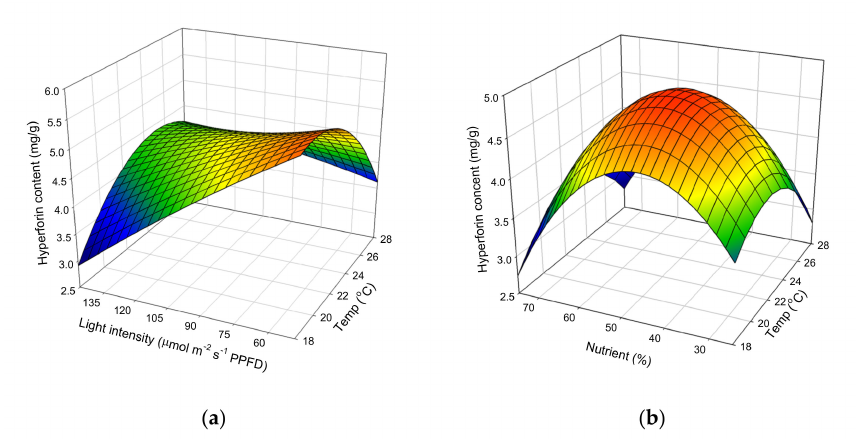
Figure 4. Response surface plot showing the e ff ects of cultivation ( a ) temperature, light intensity, and their mutual interaction on the hyperforin content. ( b ) temperature, nutrient concentration, and their mutual interaction on the hyperforin content.